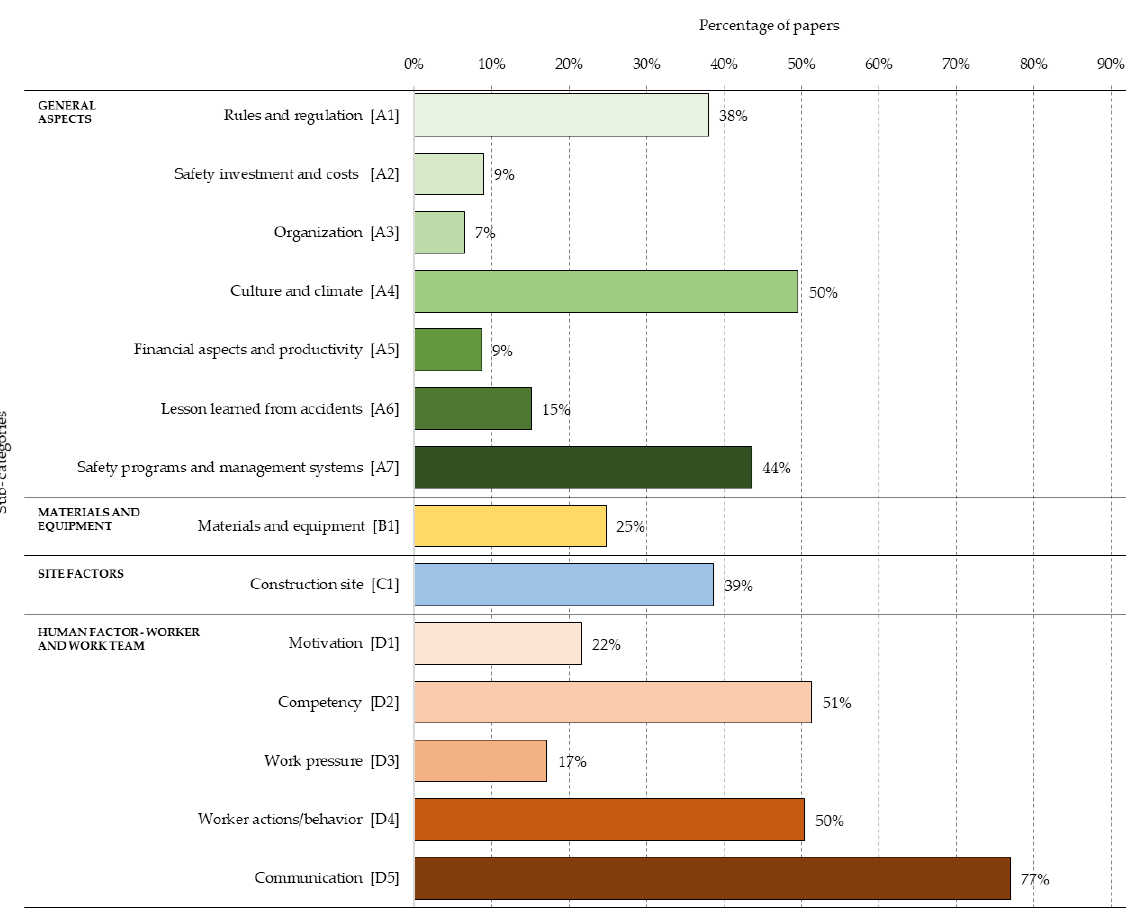
Figure 6. Percentage distribution of factors in each of the 14 sub-categories.